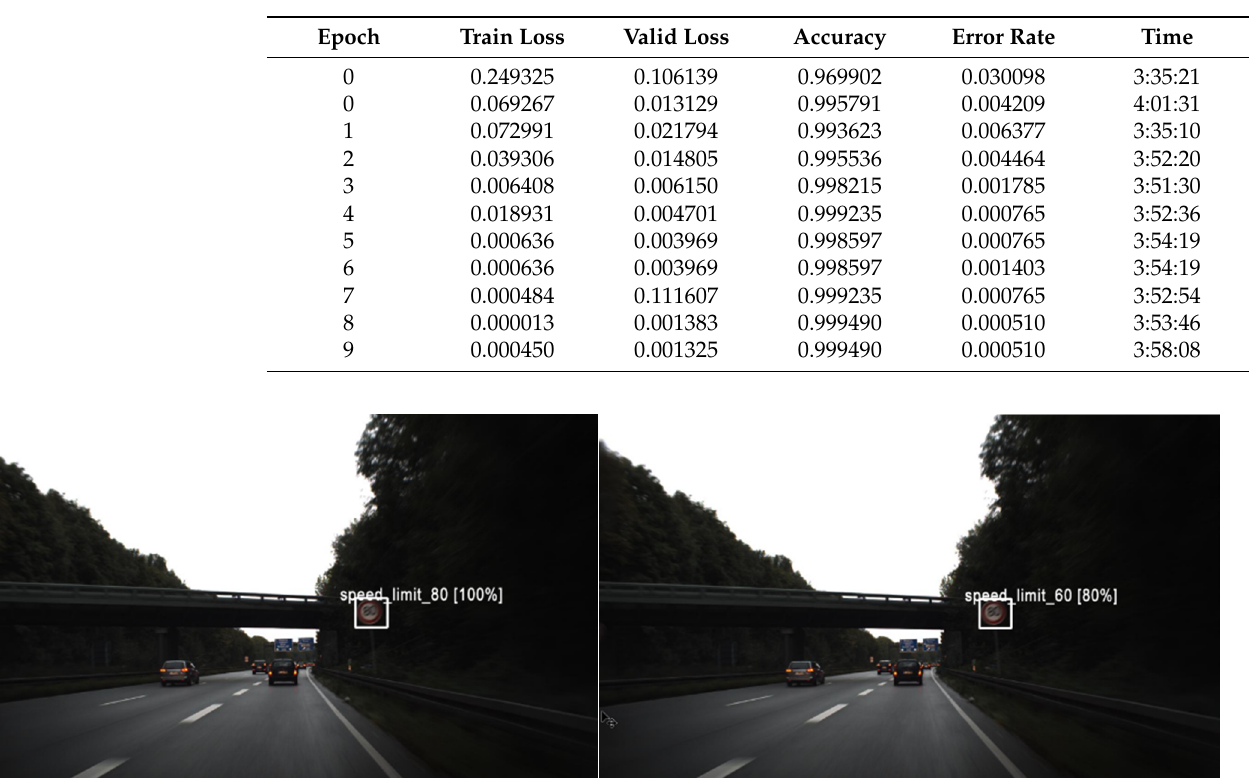
Table 12. Results of the DenseNet 201.